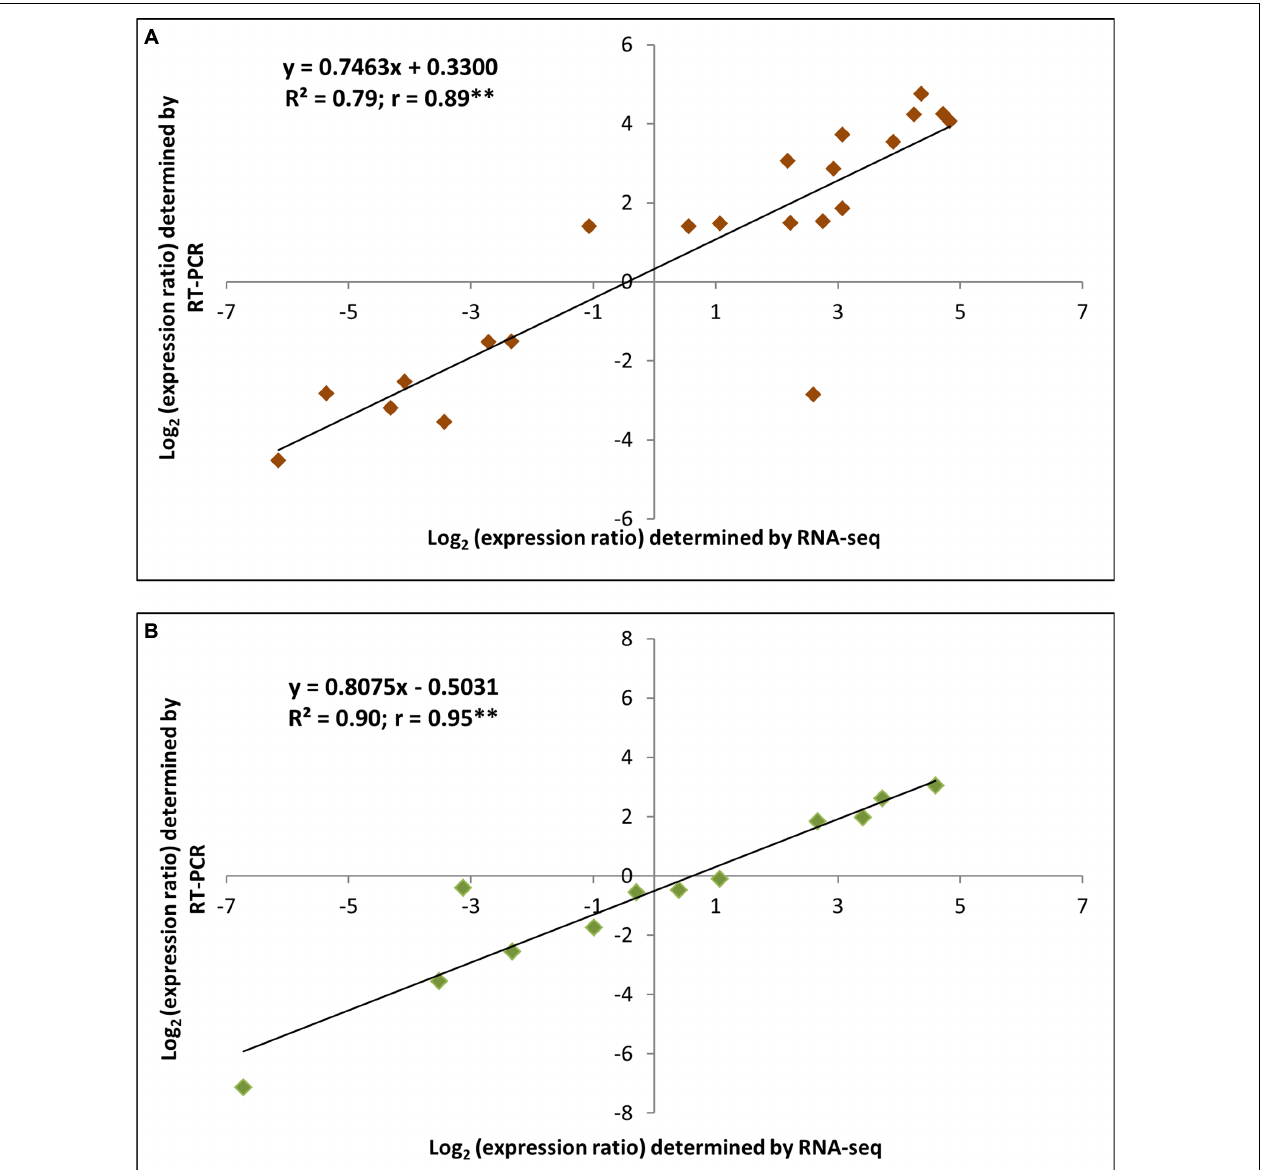
FIGURE 7 | Linear regressions involving the RNA sequencing data and the RT-qPCR validation data expressed in terms of Log 2 FC. The fold change (FC) was calculated as the ratio between the drought-stressed and control plants. (A,B) indicate roots and leaves, respectively. ∗∗ Significant Pearson’s correlation coefficient at P ≤